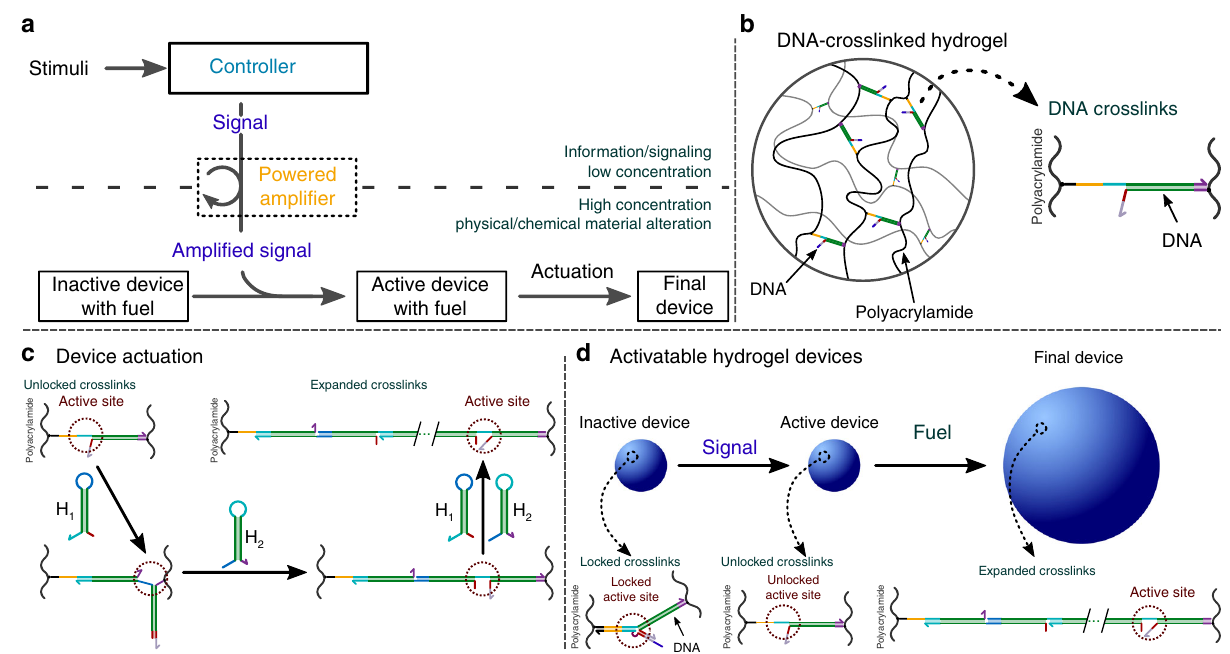
Fig. 1 Scheme for controlled expansion of DNA-crosslinked hydrogels gated by biomolecular signals. Colors within DNA strands show sequence domains, drawn to scale; complementary regions are shown in the same colors. a Device architecture. A controller interprets stimuli and decides whether to switch the device from an inactive to an active state. The controller takes low-concentration inputs and processes them with low-concentration molecular circuit elements; the output is then ampli fi ed to activate the high-concentration crosslinks within the device that interact with high-concentration fuel to drive material shape change. b In a DNA-crosslinked hydrogel, hybridized DNA oligonucleotides crosslink polyacrylamide chains. c Schematic of the hairpin monomer incorporation process that drives size change. Two types of hairpin monomers are inserted into crosslinks in alternating series at a single active site. d Control over whether size changes is achieved by control over device activation through crosslink unlocking. Unlocked crosslinks can extend